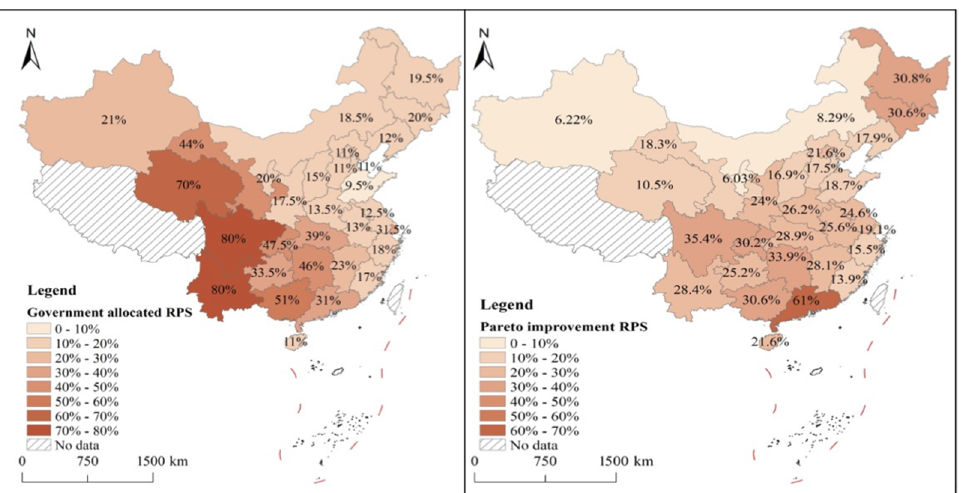
Figure 3. Comparison of the 2018 Pareto Efficiency RPS Allocation Scheme ( left ) with the RPS Allocation Scheme ( right ) published by the NEA.